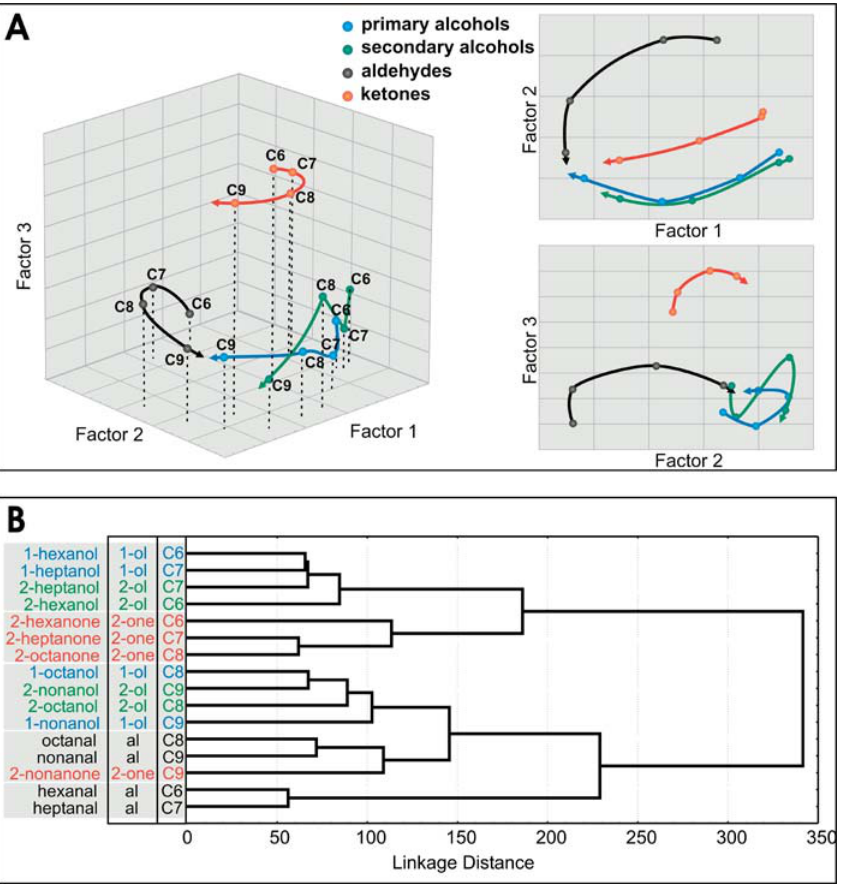
Figure 6. A Putative Honeybee Olfactory Space (A) Left: The olfactory space is defined on the basis of the three principal factors that accounted for 76% of overall data variance after a PCA performed to represent the relative relationships between odorants. Primary alcohols are indicated in blue, secondary alcohols in green, aldehydes in black, and ketones in red. Different chain-lengths are indicated as C6, C7, C8, and C9, which corresponds to their number of carbon atoms. For each functional group, arrows follow the increasing order of carbon-chain lengths. Right: Chain length was very clearly represented by factor 1. C6 to C9 molecules are ordered from right to left. The chemical group was mostly represented by factors 2 and 3. Whereas factor 2 separated mostly aldehydes from alcohols, with ketones falling between them, factor 3 separated ketones from all other odours. None of these three factors separated primary and secondary alcohols. (B) Euclidean cluster analysis. The analysis separated odours mostly according to their chain length. Linkage distance is correlated to odour distances in the whole 16-dimension space. The farther to the right two odours/odour groups are connected, the higher the perceptual distance between them (odour colour codes are the same as in [A]). DOI: